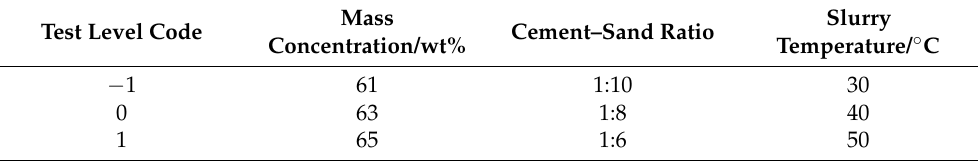
Table 6. Endogenous factor parameters and level